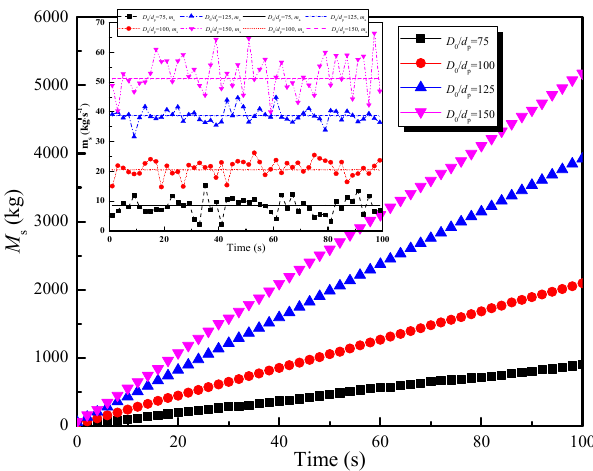
Figure 26. The variation in mass flow during the discharge process with variations in the geometry factor of vertical sinter cooling bed (VSCB). Inset: mass flow rate and mean value of the mass flow rate for different geometry factors.